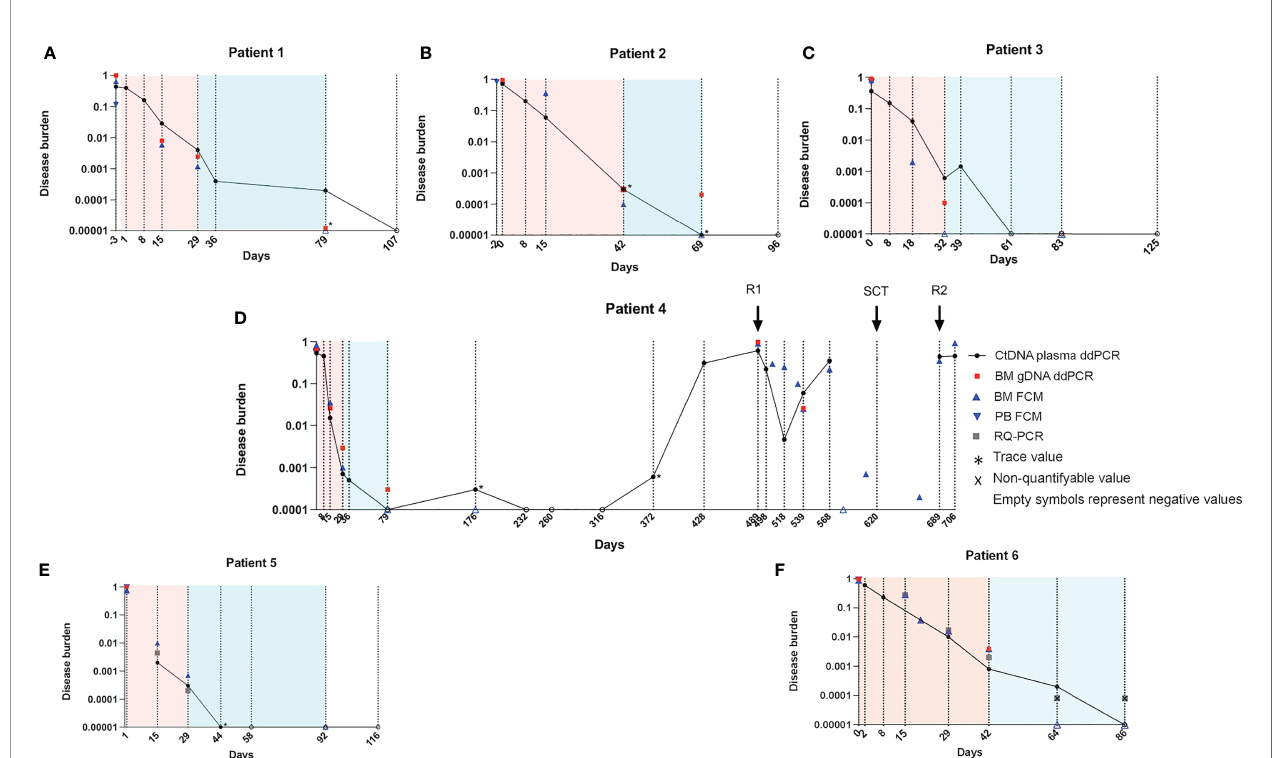
FIGURE 5 | Kinetics of leukemic targets in plasma and BM by ddPCR and routine evaluation methods. Plasma ctDNA ratio by ddPCR (black circles) in patients 1-6 (A – F) . BM gDNA ratio by ddPCR (red squares). Asterisks denote trace amounts (<3 positive droplets). Empty symbols denote negative values. Cells with LAIP by FCM in BM (blue triangles) and in PB (inverted blue triangles). In the panels from patients 5 and 6 (both T-ALL), RQ-PCR data are shown (gray squares). Note that the lower level of detection for the RQ-PCR assay is 0.0001; RQ-PCR positive, non-quanti fi able samples (black cross). BM, bone marrow; ddPCR, droplet digital PCR; ctDNA, cell-free tumor DNA; gDNA, genomic DNA; LAIP, leukemia-associated immunophenotype; FCM, fl ow cytometry; PB, peripheral blood; T-ALL, T-cell acute lymphoblastic leukemia; RQ-PCR, real-time quantitative